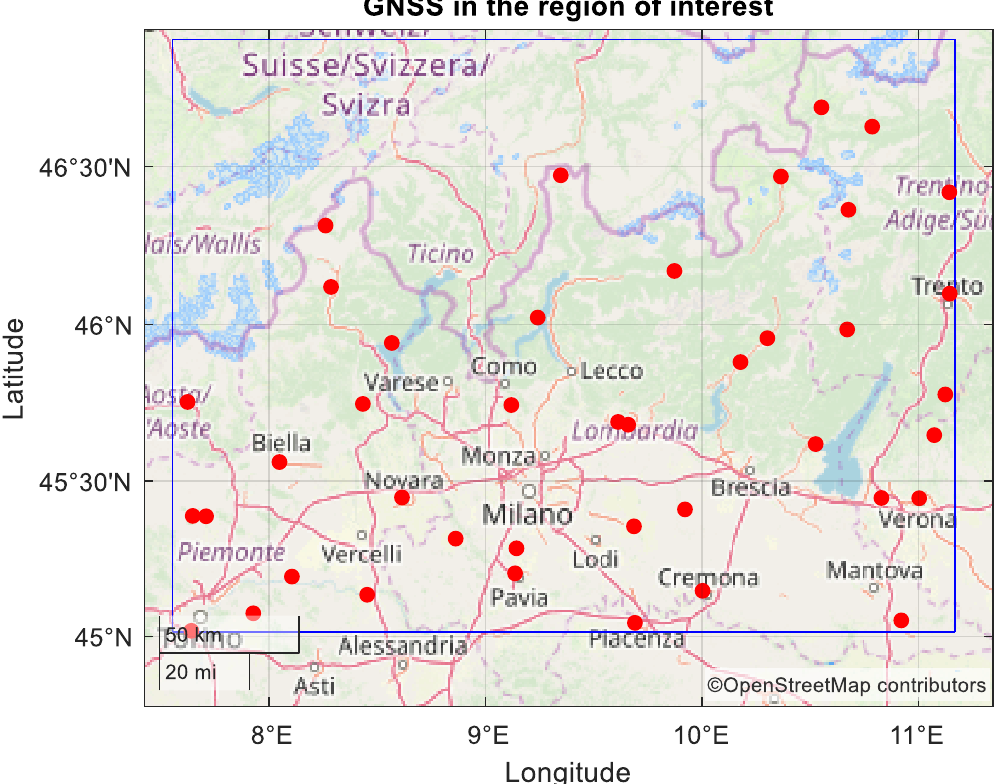
Figure 9. GNSS (Global Navigation Satellite System) stations (red dots) in the area of interest (blue